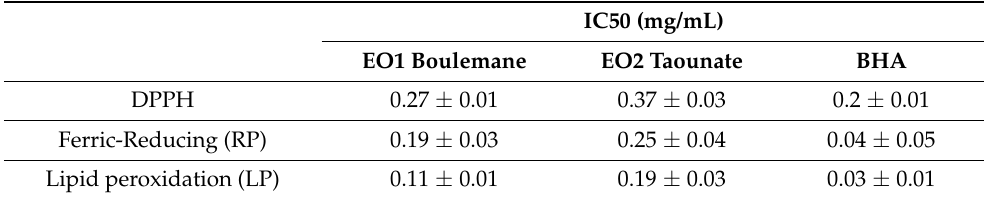
Table 2. Antioxidant activity of O. compactum essential